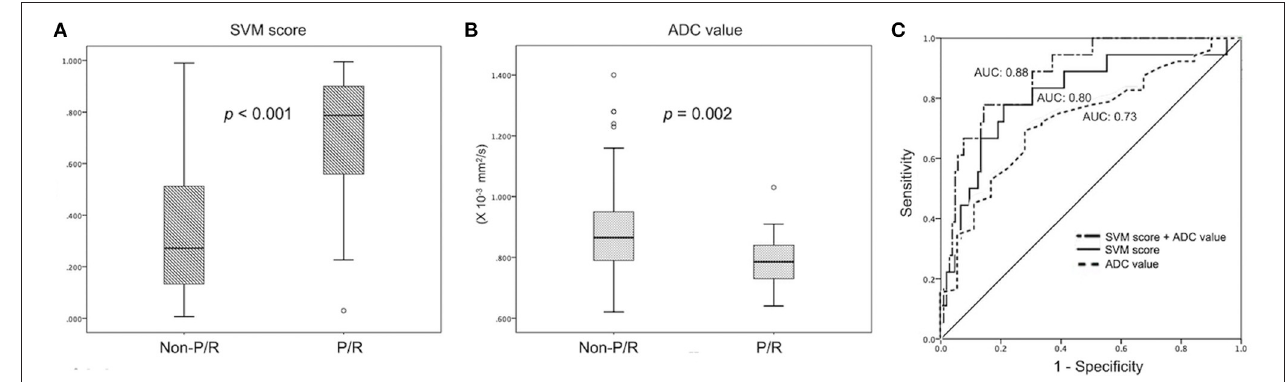
FIGURE 4 | Statistically significant differences ( p < 0.05) (Mann–Whitney U test) are observed in the box plot of (A) SVM score and (B) ADC value to differentiate between patients with and without P/R. (C) Receiver operating characteristic (ROC) curves of SVM score and ADC value for the prediction of P/R in meningiomas,